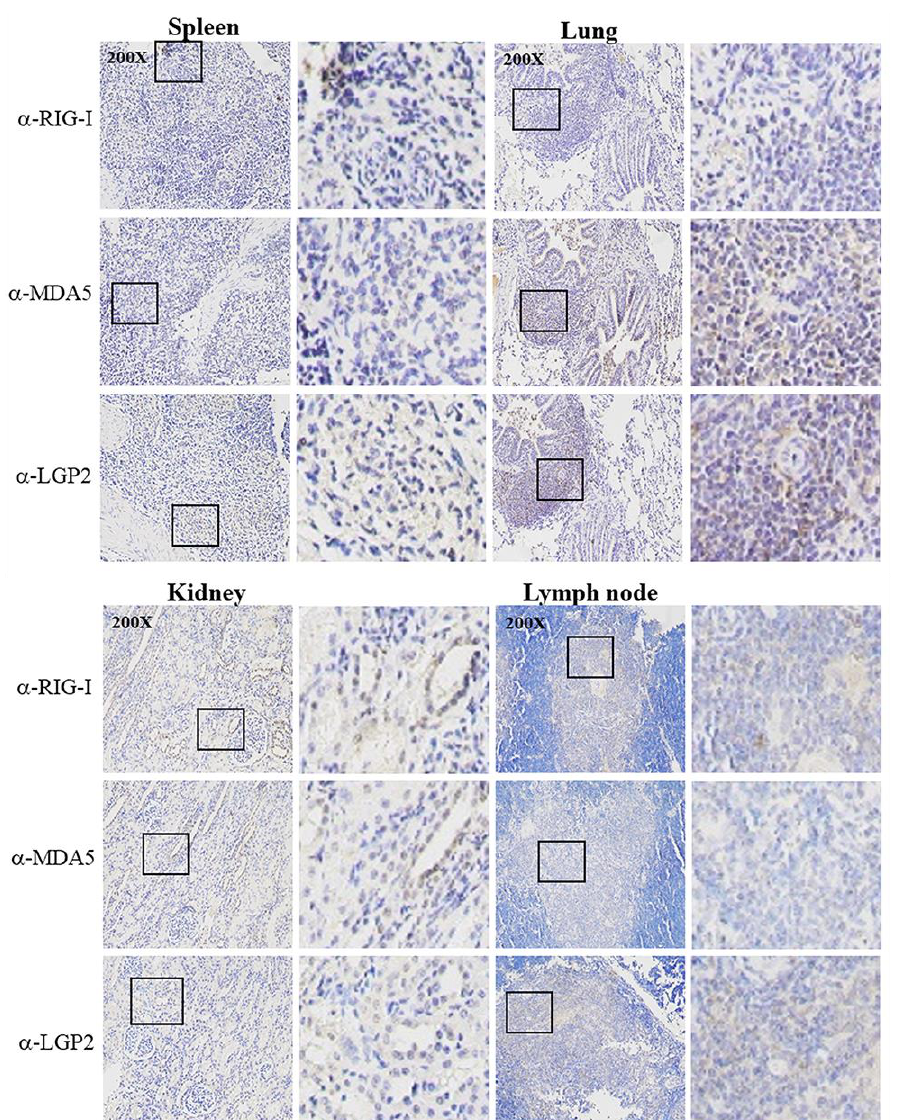
Figure 7. Immunochemistry analysis of RLR expressions in various tissues from PRRSV-infected pigs. Tissues from PRRSV-infected pigs including heart, liver, spleen, lung, kidney and lymph nodes were collected for tissue sectioning. Tissue sections were stained with pRIG-I mAb, pMDA5 mAb and pLGP2 (B9-2) mAb, respectively, followed by hematoxylin counterstaining. The staining results were observed under a microscope at a magnification of 200 × , and the boxed areas have been enlarged and are shown on the right of each images. There was no reaction of normal pig tissues with RLR mAbs (not